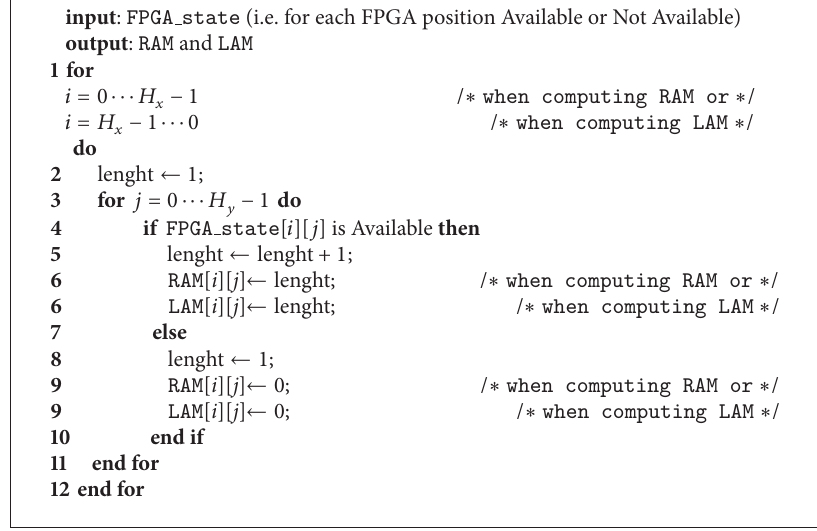
Algorithm 3: EAC heuristic: Compute RAM() and Compute LAM()